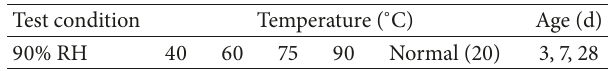
Table 1: Concrete test